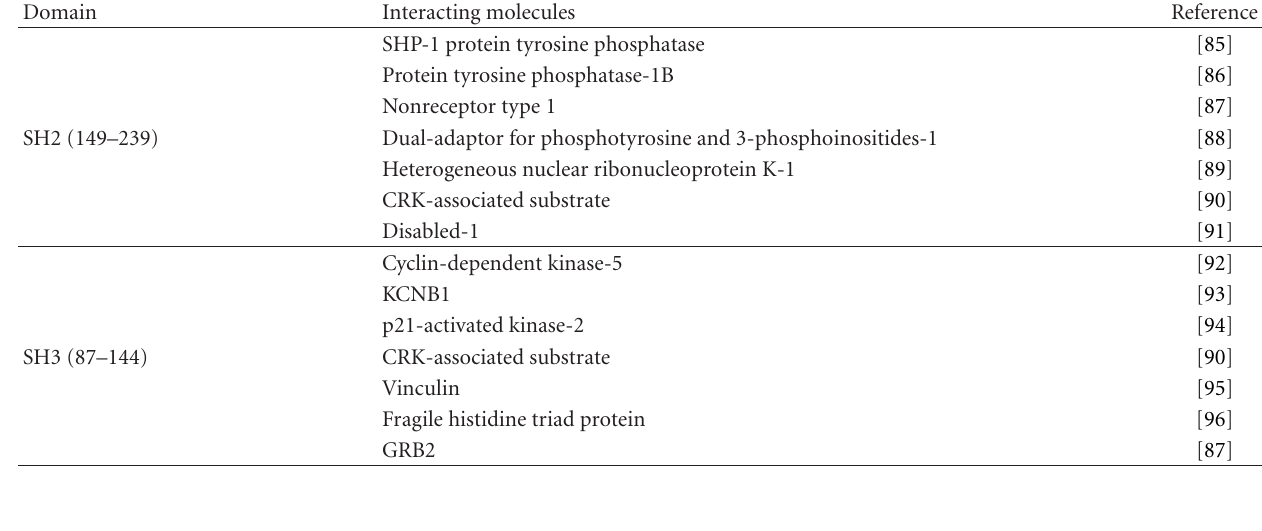
Table 2: Src-interacting molecules corresponding to SH2 or SH3.